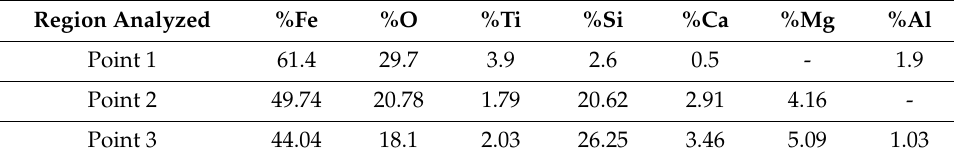
Figure 2. Micrograph of titaniferous sands prior to heat treatment. Table 1. EDS analysis, in atomic percentage.